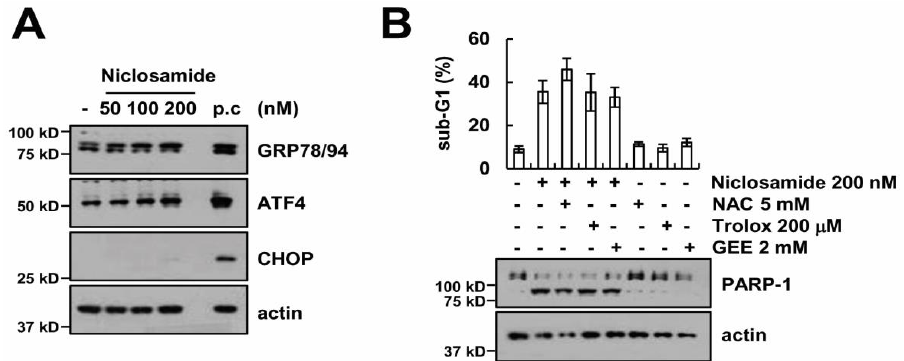
Figure 6. Niclosamide plus TRAIL-induced apoptosis is independent of endoplasmic reticulum (ER) stress and reactive oxygen species (ROS) generation. ( A ) The protein expression were determined by Western blotting in Caki cells after treatment with niclosamide (50–200 nM) or 2 μM brefeldin A (positive control; p.c.) for 9 h. ( B ) The apoptosis levels and protein expression were detected by flow cytometry and Western blotting in Caki cells after pretreatment with 5 mM NAC, 200 μM trolox, and 2 mM GEE for 30 min, followed by treatment with 200 nM niclosamide and 50 ng/mL TRAIL for 24 h. The values in graph ( B ) represent the mean ± SEM of three independent samples.